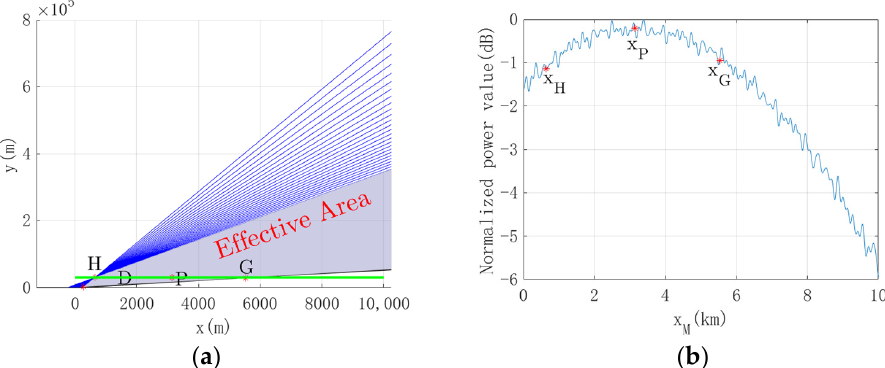
Figure 9. Change of main-lobe power within the effectively compensated area using beam scanning; ( a ) moving radiant source M trajectory; ( b ) variation of main-lobe power value with x M